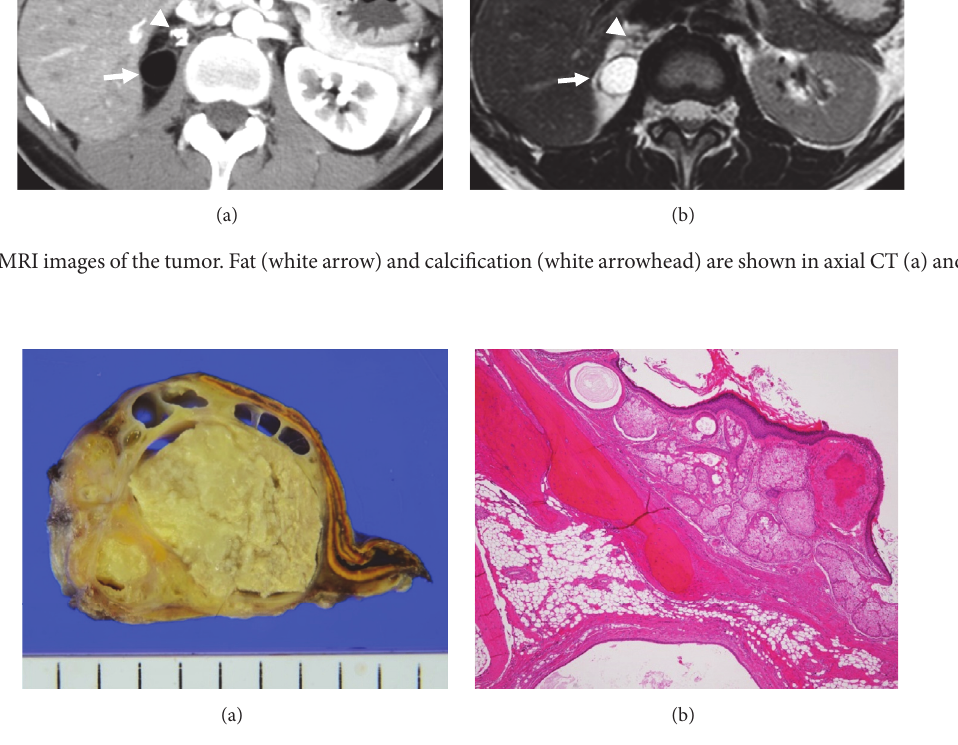
Figure 2: (a) Macroscopic findings of the resected tumor. The tumor contained cystic and solid components with adipose tissue. The right adrenalglandiscompressedbythetumor.(b)Microscopically,thewallofthecysticcomponentwaslinedbykeratinizedsquamousepithelium and a mixture of mature components including sebaceous glands, cartilage, and bone in the solid